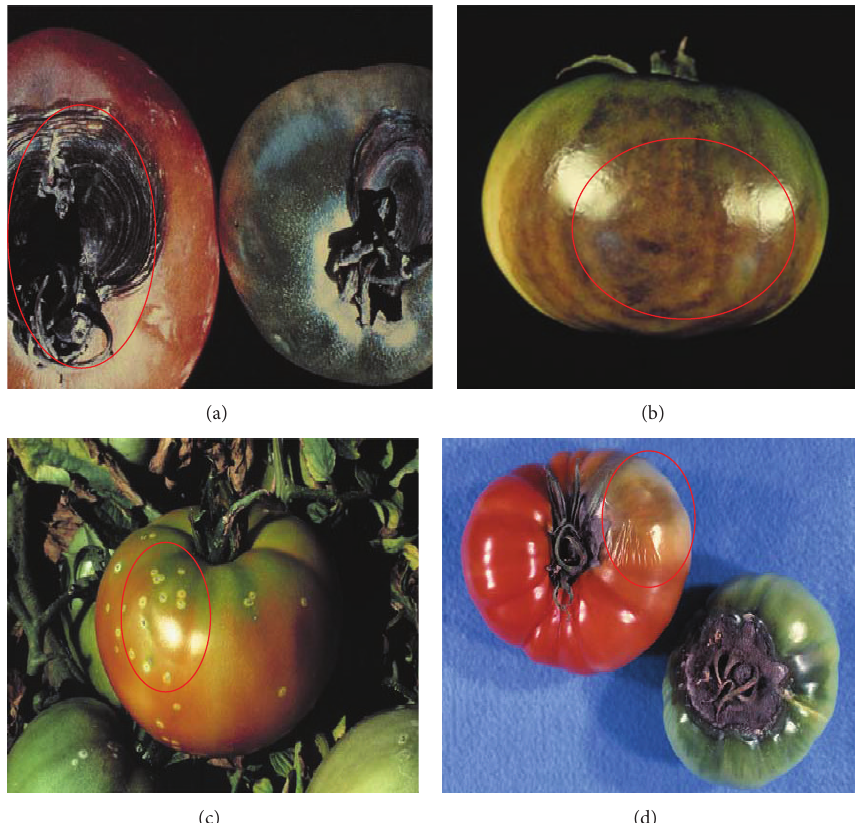
Figure 1: Different diseases effect on the tomato fruit: (a) early blight, (b) late blight, (c) bacterial canker, and (d) gray mold.